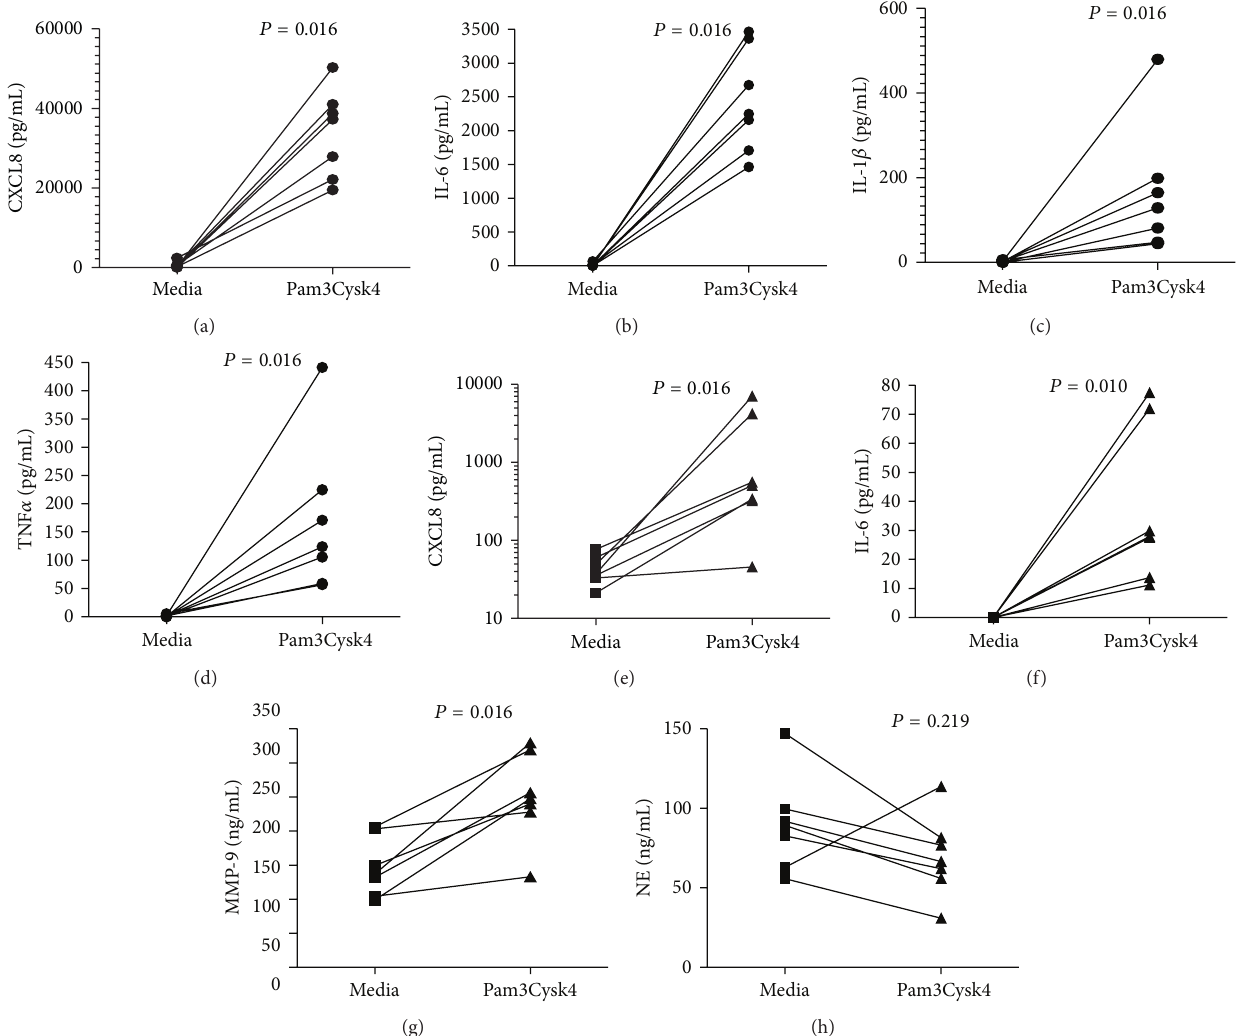
Figure 6: Release of inflammatory mediators from mononuclear cells and granulocytes isolated from patients with COPD. (a) CXCL8 release from mononuclear cells, (b) IL-6 release from mononuclear cells, (c) IL-1 𝛽 release from mononuclear cells, (d) TNF- 𝛼 release from mononuclear cells, (e) CXCL8 release from granulocytes, (f) IL-6 release from granulocytes, (g) MMP-9 release from granulocytes, and (h) NE release from